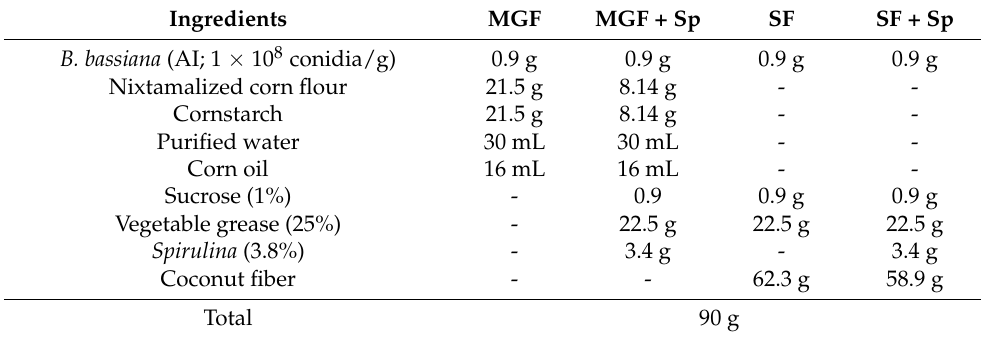
Table 1. Ingredients for mixing Beauveria bassiana conidia on microgranular formulations.